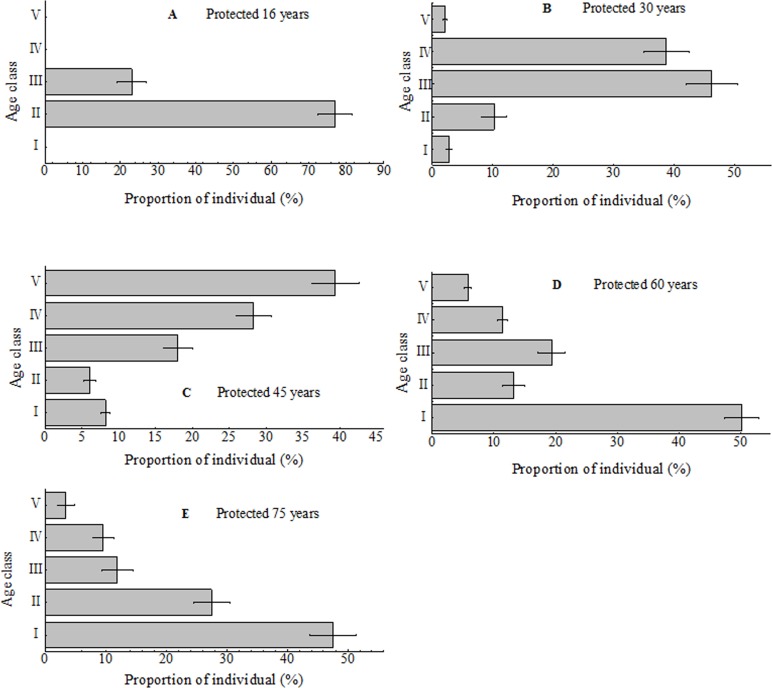
Age structure of Pinus tabulaeformis population in protected stands.The Roman numerals (I–V) in figures stand for age structures of Pinus tabulaeformis population. I seedling, H ≤ 0.30 m; II young tree, 0.30 m 2.0 m, 6.0 cm < DBH ≤ 12.0 cm; IV medium tree, 12.0 cm < DBH ≤ 20.0 cm; V big tree, DBH > 20.0 cm.